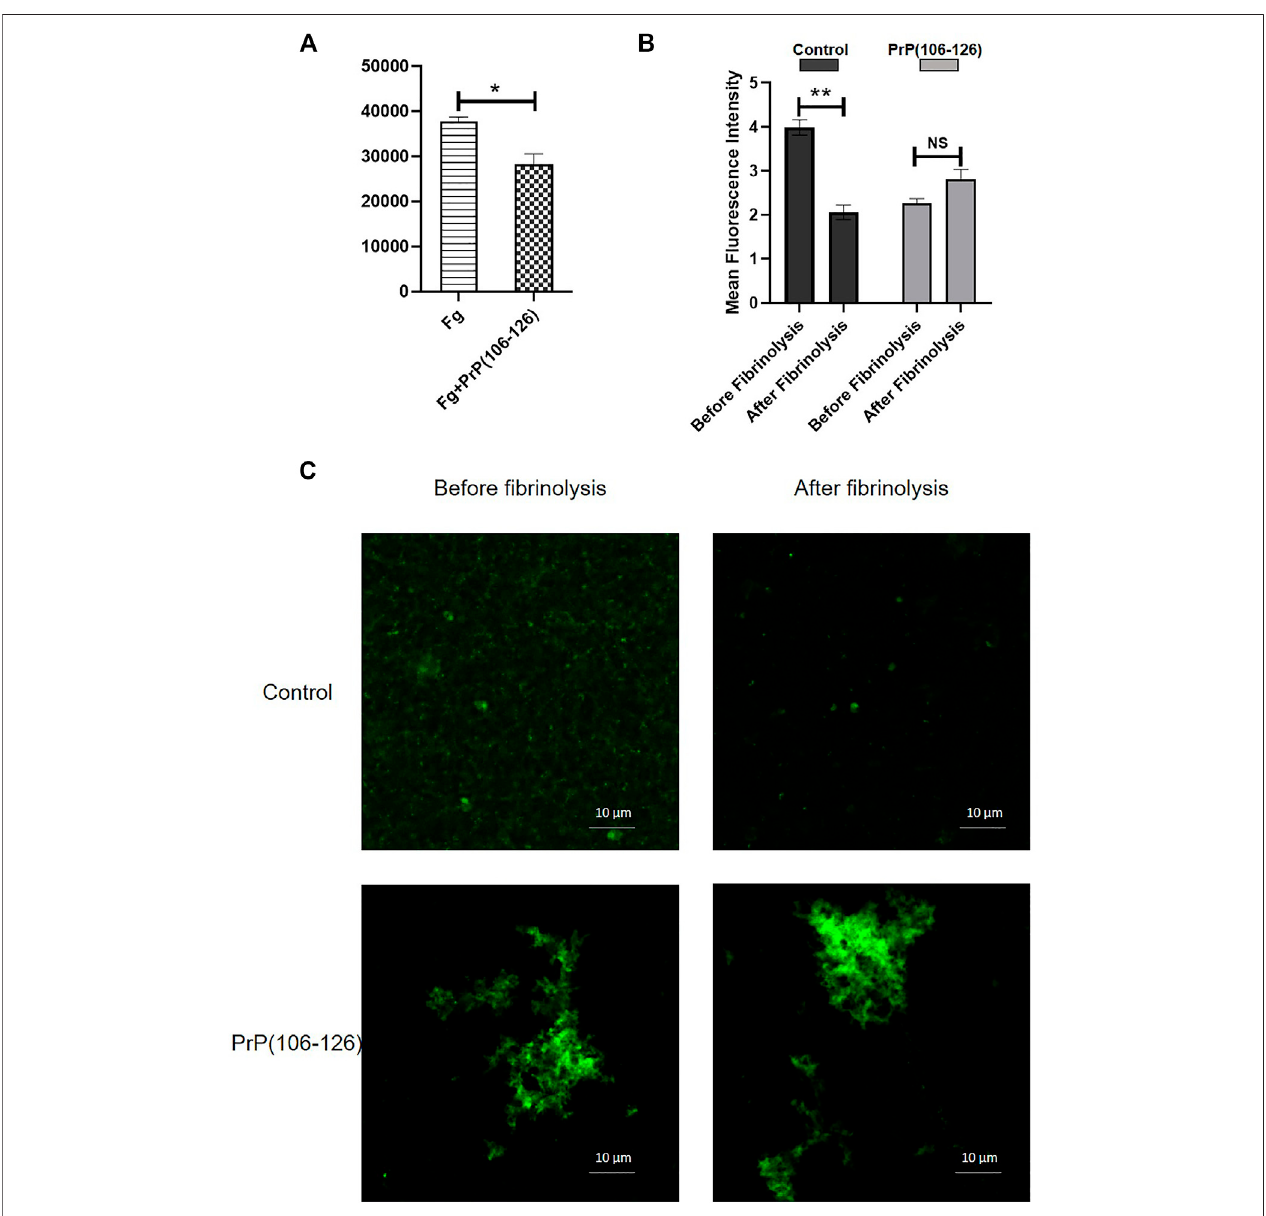
FIGURE 6 | (A) Fibrinolysis measured from the extent of release of fl uorescent degradation products from fi brin clots treated with tPA plus plasminogen. (B) Mean fl uorescence intensity of fi brin clots treated with tPA plus plasminogen for 5 min, followed by confocal microscopy. Images were analyzed using ImageJ software. (C) Confocal images showing the effect of PrP(106 – 126) on plasmin-mediated lysis of fl uorescently labeled fi brin clots. Figures are representative of ≥ 3 independent experiments (mean ± SEM, p < 0.05).